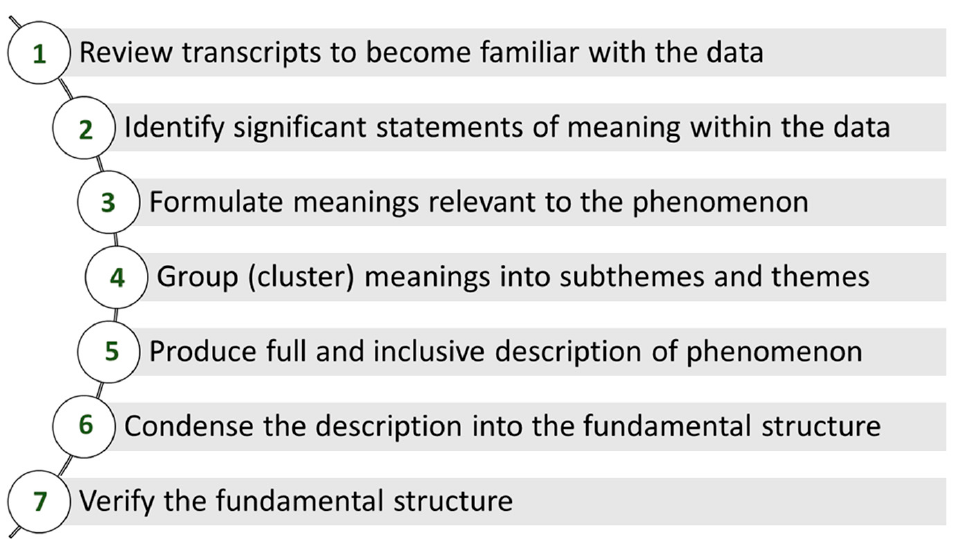
Figure 3. Colaizzi’s Analysis Process for Descriptive Phenomenology.